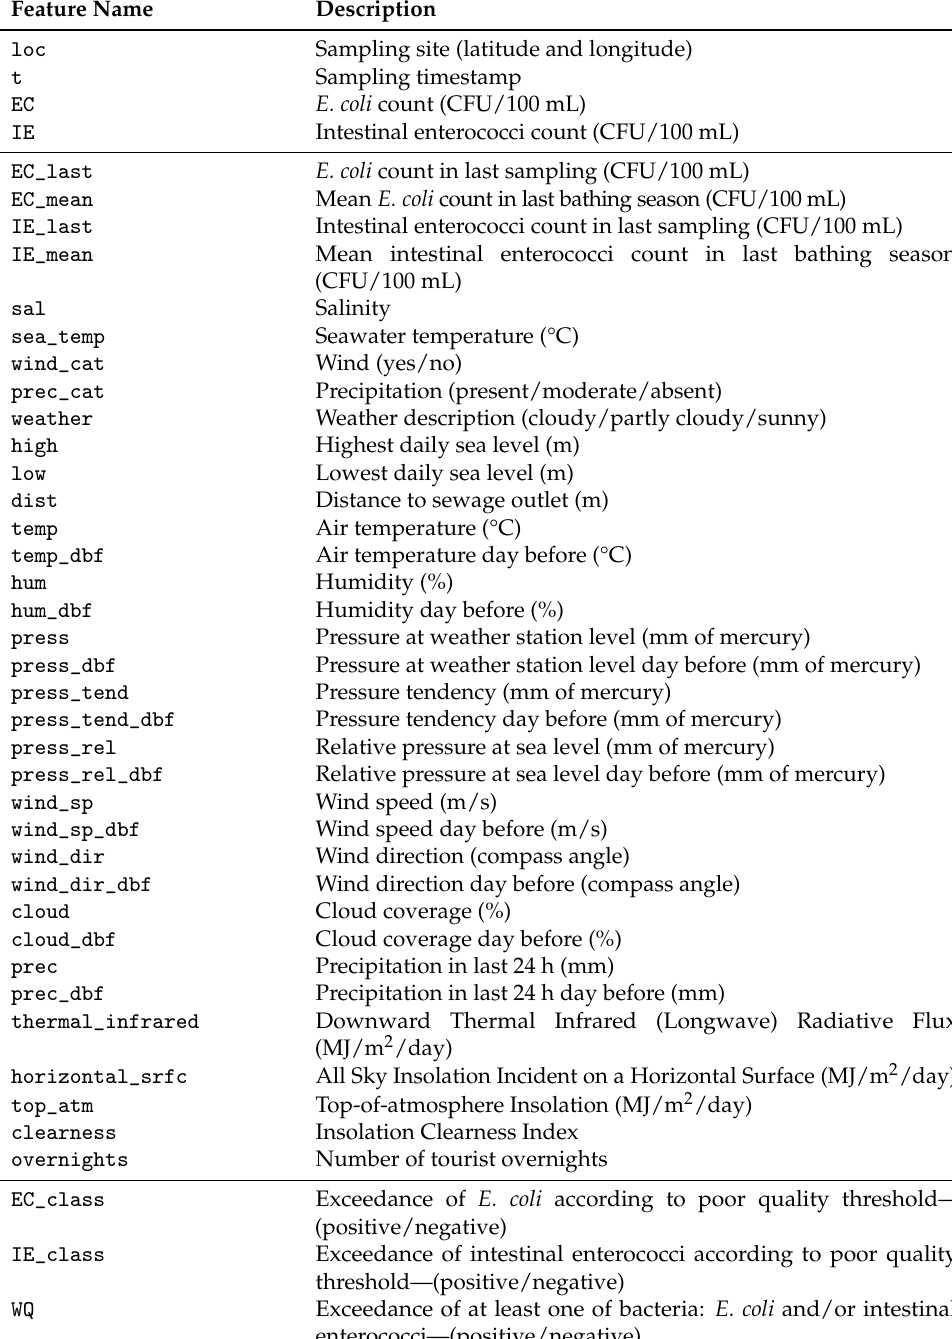
Table 2. Overview of features in data set. The first four features describing the sample are excluded from modelling, and the last three features ( EC_class , E_class and WQ ) are the ones to be modelled (dependent variables). The other 35 features are used in modelling as independent